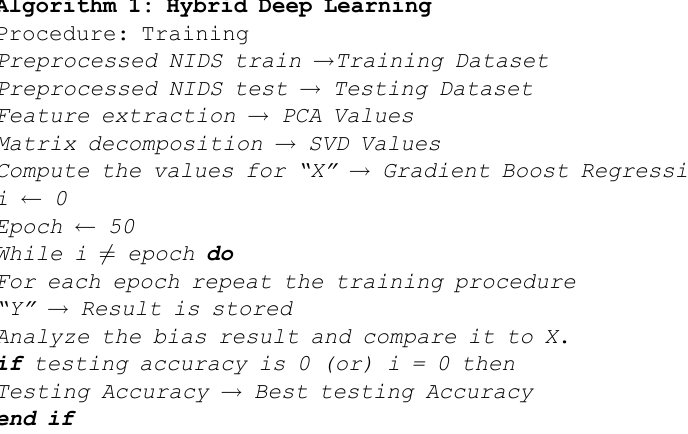
Algorithm 1: Hybrid Deep Learning